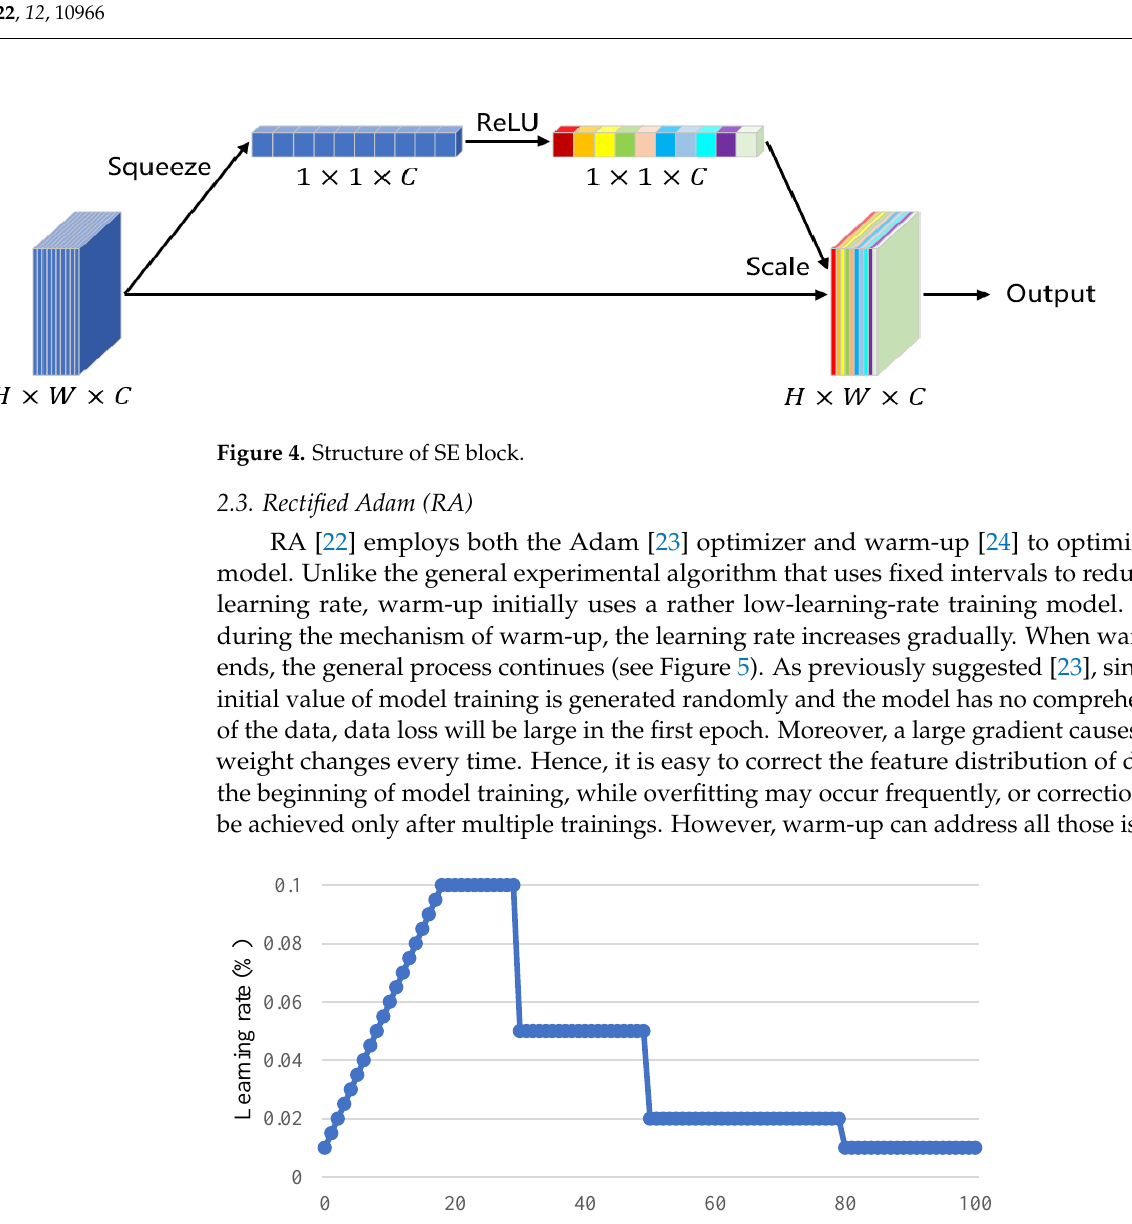
Figure 5. Learning rate changes in warm-up.